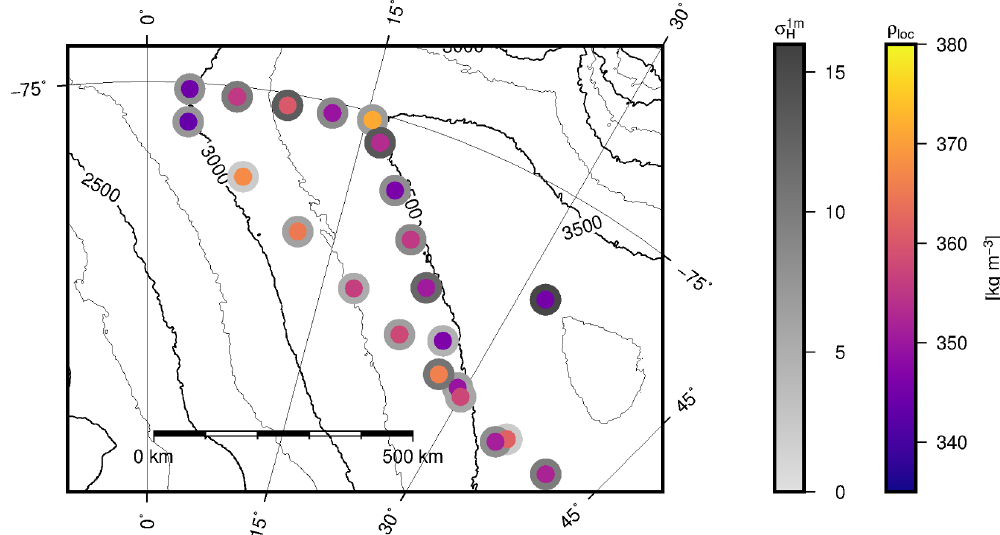
(cid:16) (cid:17) σ 1m along the traverse. The according values can be found H